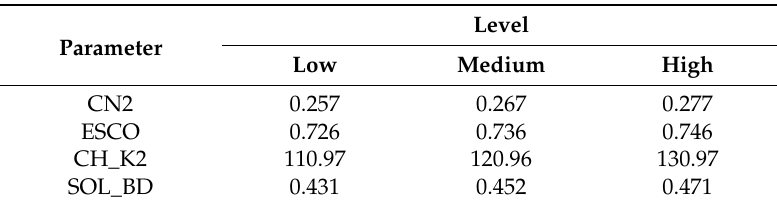
Table 2. The 3 4 factorial design scheme.